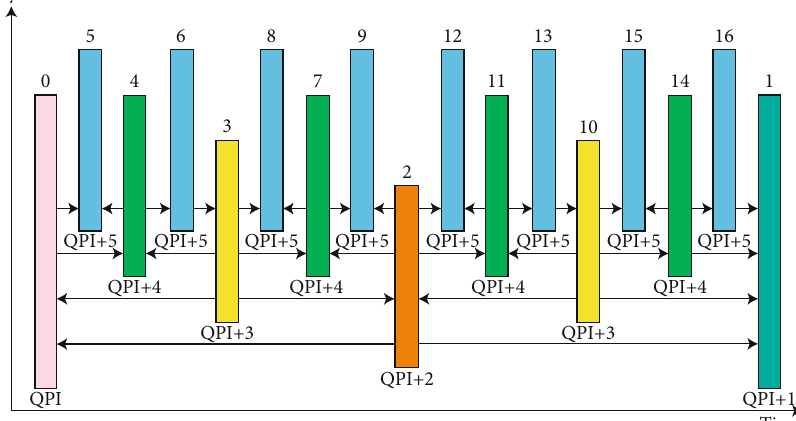
Figure 9: Random access con fi